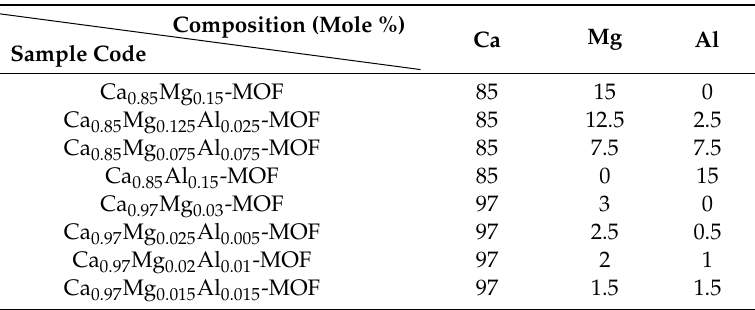
Table 1. Sample codes of